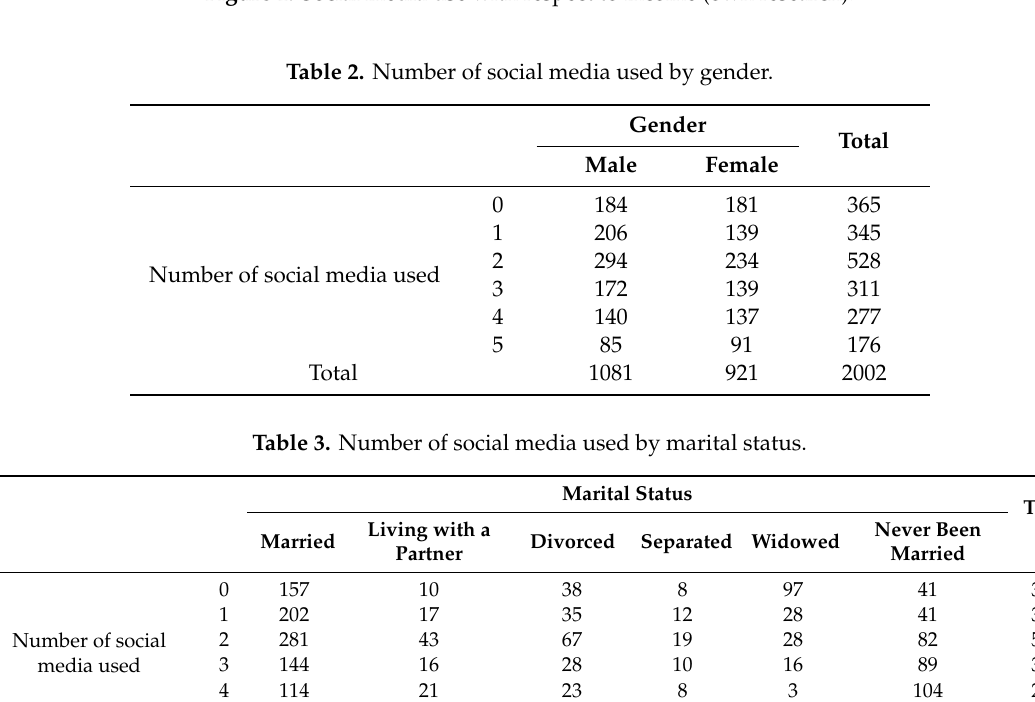
Figure 1. Social media use with respect to income (own research).